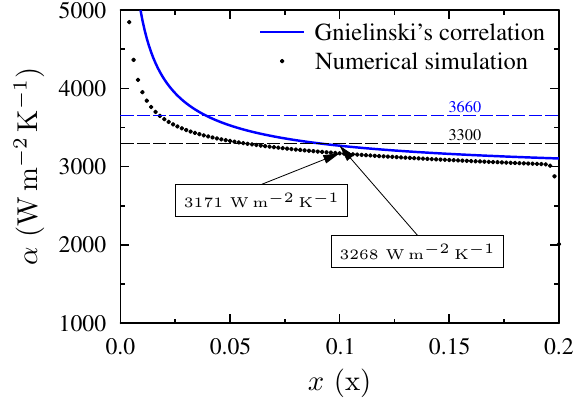
Fig. 9. A comparison of local values of the heat transfer coe ffi - cients along the measurement section. Blue color corresponds to (3), black color represents values based on the numerical simu- lation.